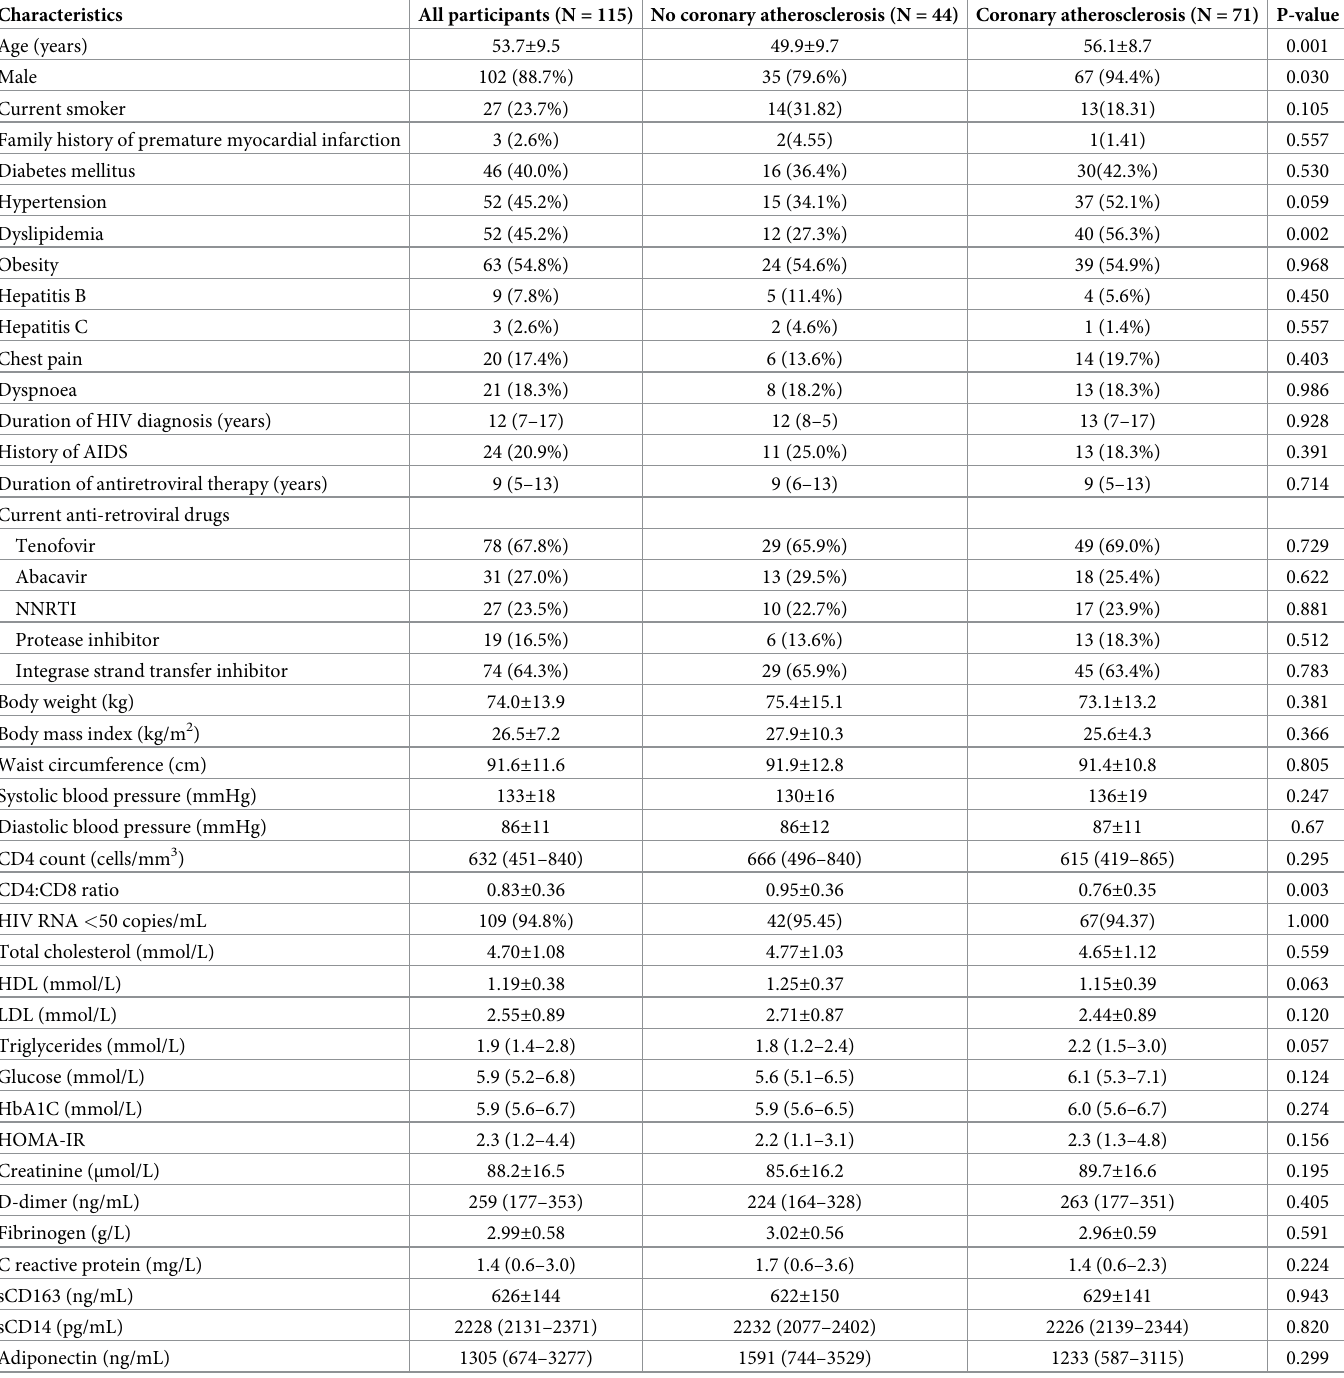
Table 1. Demographic and clinical characteristics in participants with and without coronary atherosclerosis 1 .